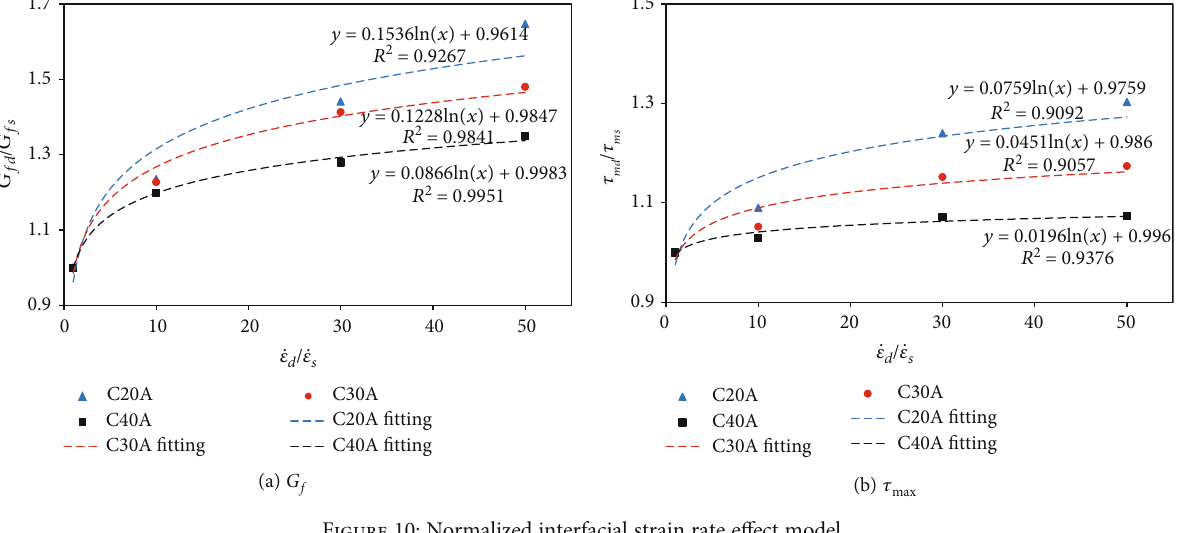
Figure 10: Normalized interfacial strain rate e ff ect